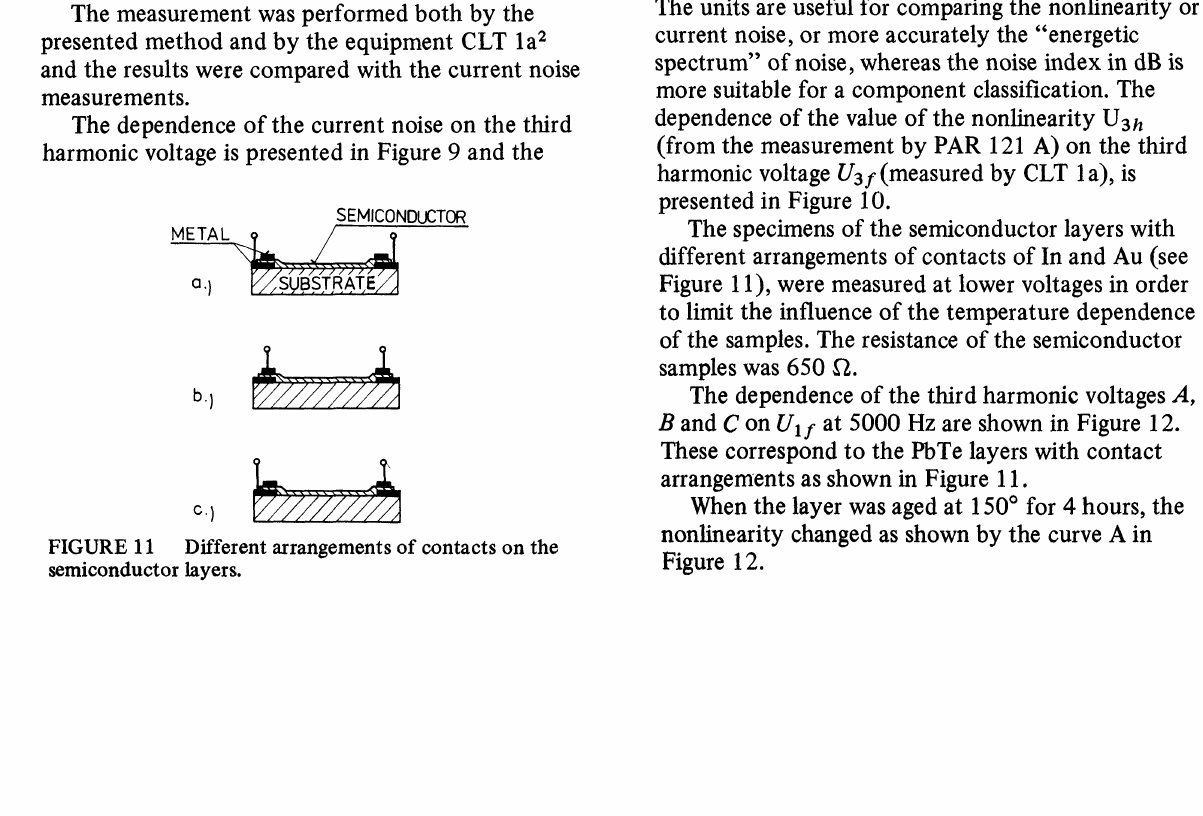
FIGURE 10 Dependence of the third harmonic U3h (obtained by the described method) on U3f (measured using the equipment CLT la). 6.